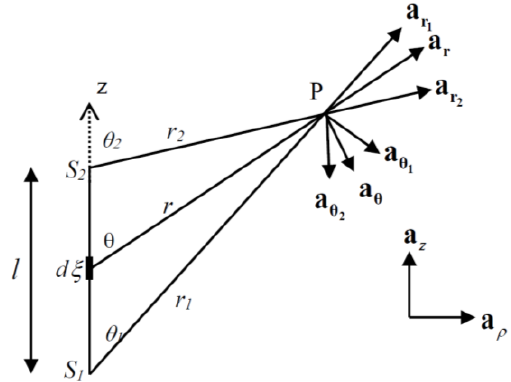
Figure 1. Geometry used in deriving the electromagnetic fields of a propagating current pulse.